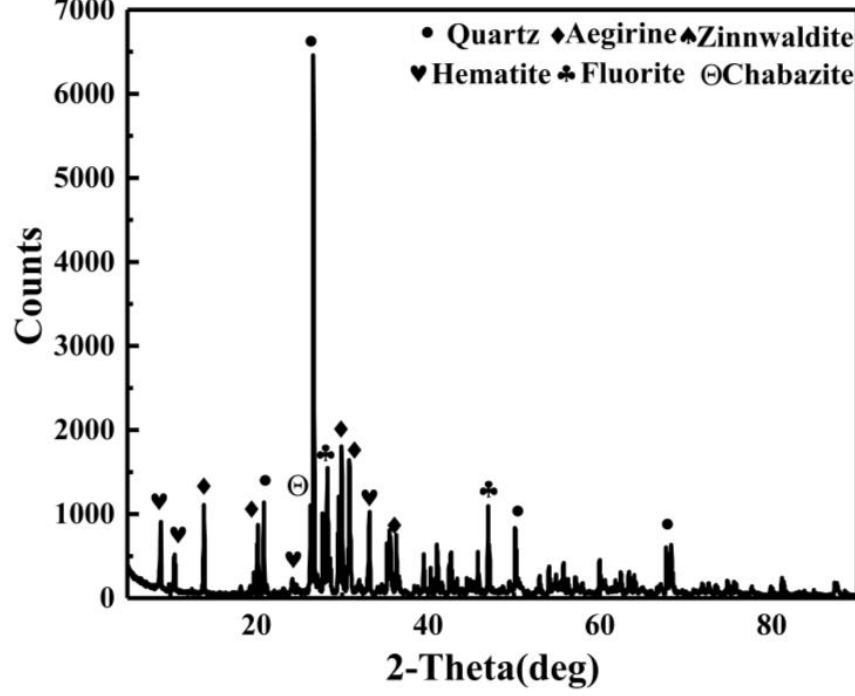
Figure 3. The XRD figure of niobium-bearing minerals in Baiyun Obo.